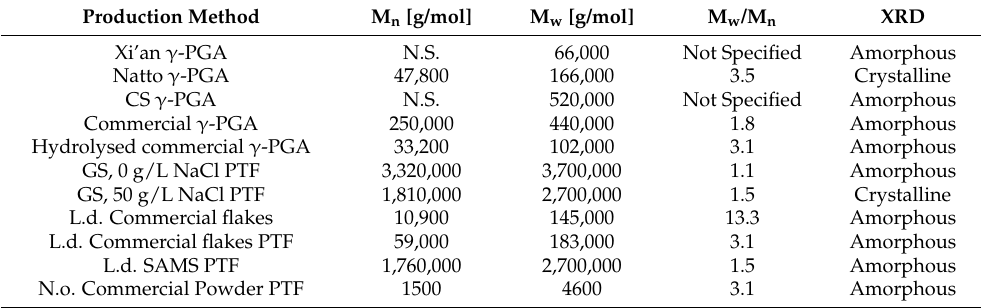
Table 2. Physico-chemical properties of commercial γ -PGA and γ -PGA synthesised from pre-extracted supplemented micro-algae media and pre-treated supplemented macro-algae media. A detailed summary of the cultivation media components (where applicable) can be found within Table 1. L.d.— Laminaria digitata , PTF: post-tangential flow purification. Production